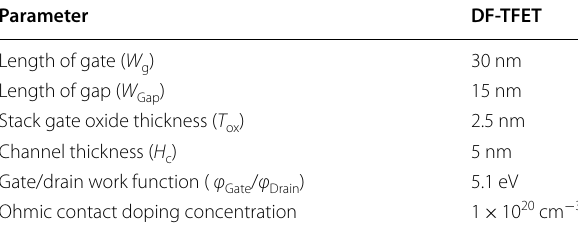
Table 1 Main parameters of